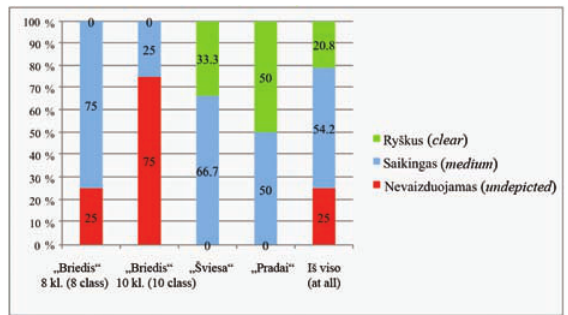
Fig. 9 . Graphic originality in the analysed economic maps of scholastic geographical